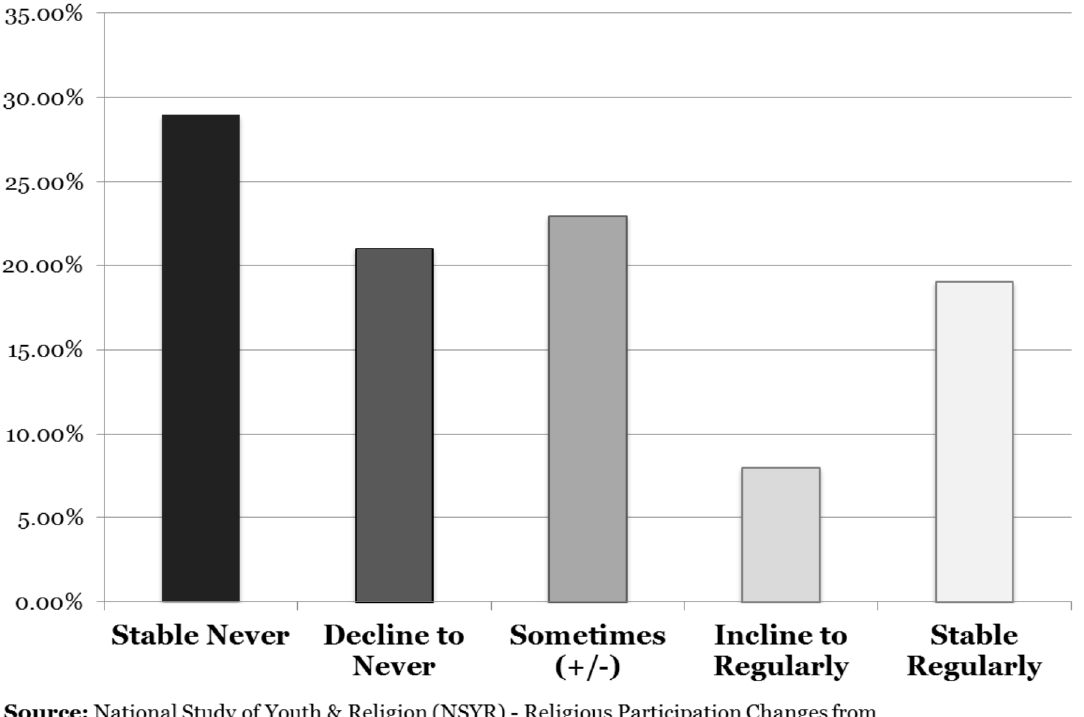
Figure 1. Religious Participation Over Time in Adulthood Transitions.